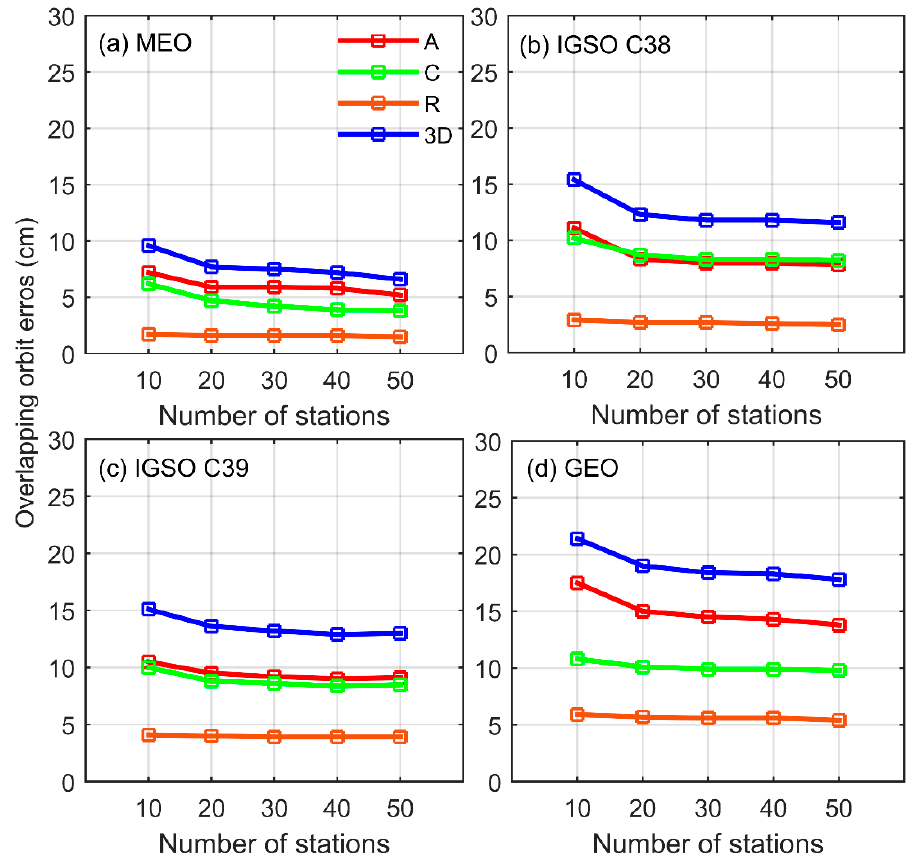
Figure 7. Comparison of BDS-3 orbit accuracy obtained with different station selection schemes for” MEO satellites ( a ); IGSO satellite C38 ( b ); IGSO satellite C39 ( c ); and GEO satellite C59 ( d ).